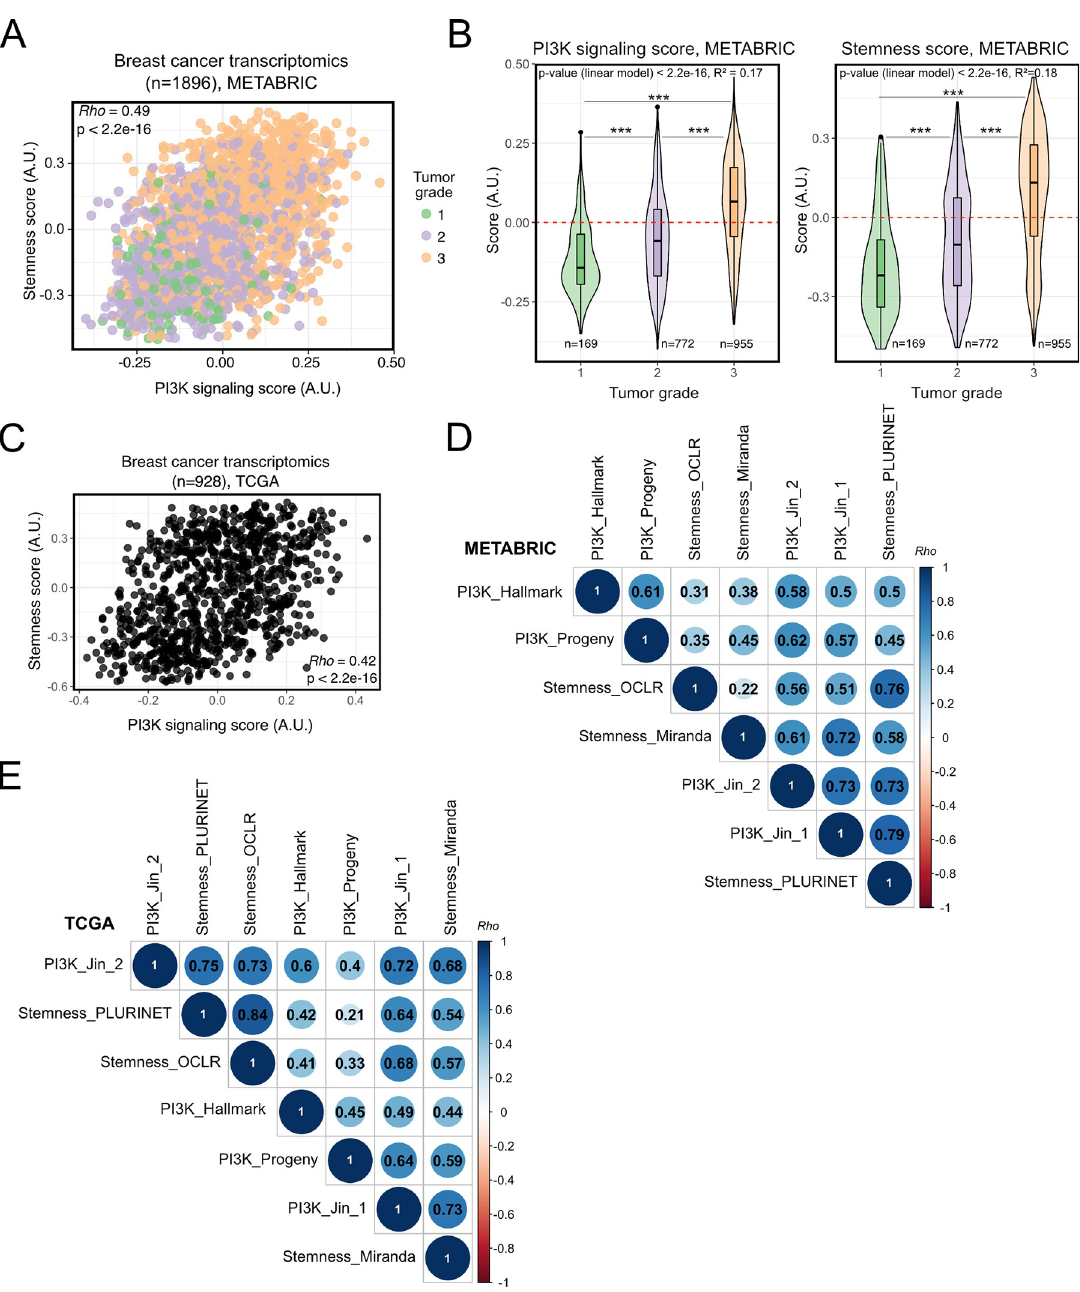
Fig 1. Transcriptionally-inferred PI3K pathway activation and breast tumor stemness/grade exhibit significant, positive association. (A) Rank-based (Spearman’s Rho ) correlation analysis of the relationship between transcriptionally-inferred PI3K pathway activity and stemness scores, evaluated across METABRIC breast cancer transcriptomes. Scores were determined using Gene Set Variation Analysis (GSVA) with mSigDB “HALLMARK_PI3K_ AKT_MTOR_SIGNALING” (for PI3K activity score) and “MUELLER_PLURINET” (for stemness score) gene signatures [25,29,30]. Gene lists used are included in Supplementary Tables 1 and 2. (B) PI3K signaling and stemness score distributions across breast cancer grade (METABRIC). ��� p � 0.001 according to one-way ANOVA with Tukey’s Honest Significant Differences method. The global p- value for each linear model is indicated within each plot. (C) As in (A) but based on TCGA breast invasive carcinoma (BRCA) transcriptomic data. (D) Rank-based correlation analyses of the stemness (PluriNet-based) and PI3K (mSigDB-based) scores used in the current study against published and independently-derived transcriptional indices for stemness and PI3K signaling, across METABRIC breast cancer transcriptomic data. Individual Rho coefficients are shown within the respective circles whose sizes are matched accordingly. Only significant correlations are shown (family-wise error rate < 0.05). E) As in (D) but based on TCGA BRCA